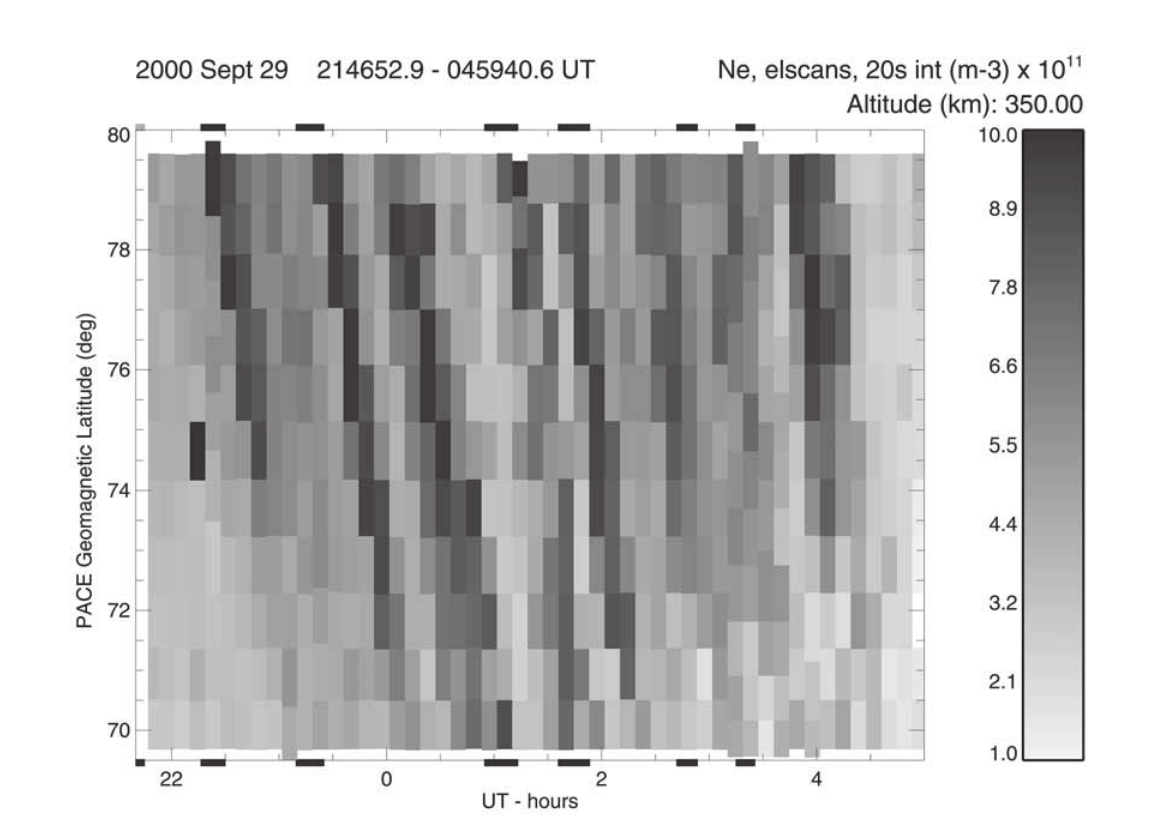
Fig. 2. F region (350 km altitude) plasma density in a latitude-time diagram, obtained from ISR measurements. Each rectangle represents one 20-s integration cell expanded to the 8-min duration of the respective back-and-forth scan. The full rectangles along the top and bottom abscissae represent the time intervals from which satellite radio signals were used to reconstruct tomographic